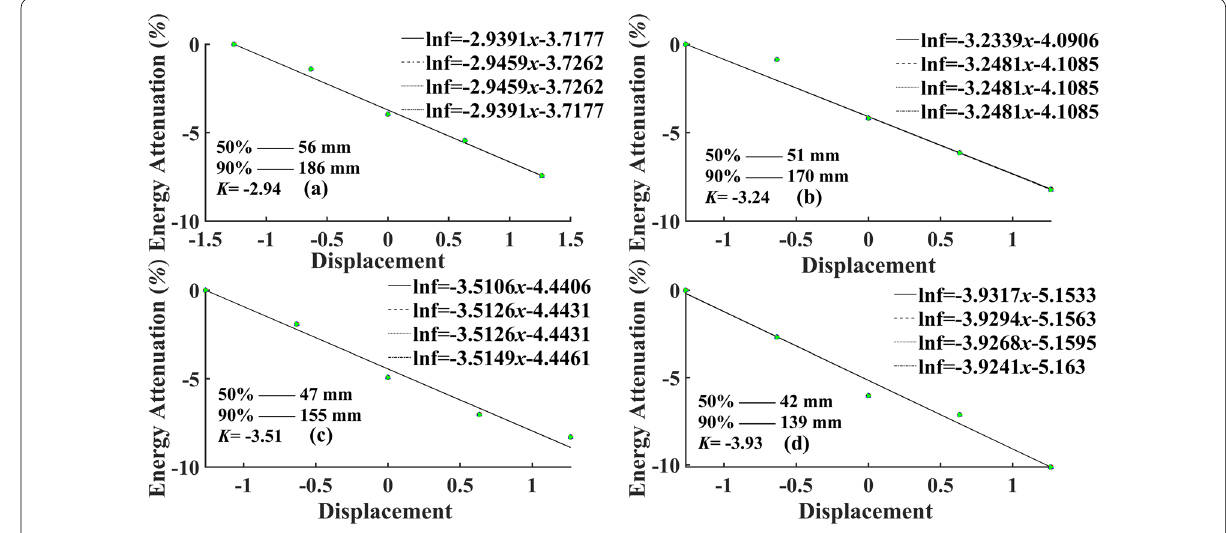
Fig. 7 Fitting curve of AE surface transverse wave energy attenuation